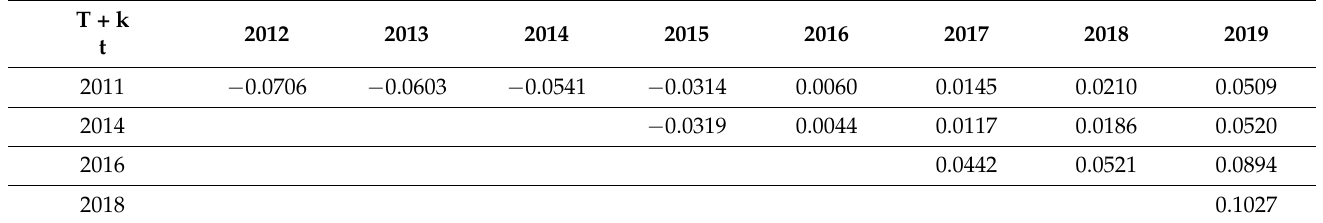
The overall index changed from negative to positive spatio-temporal correlation